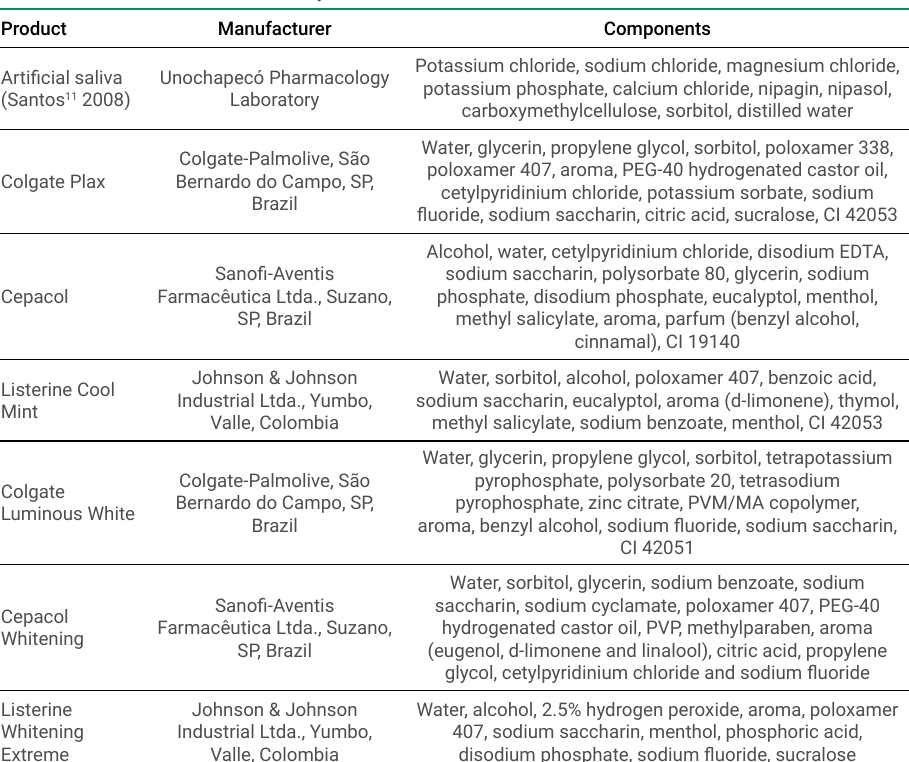
Table 1. Substances used in the study Product Manufacturer